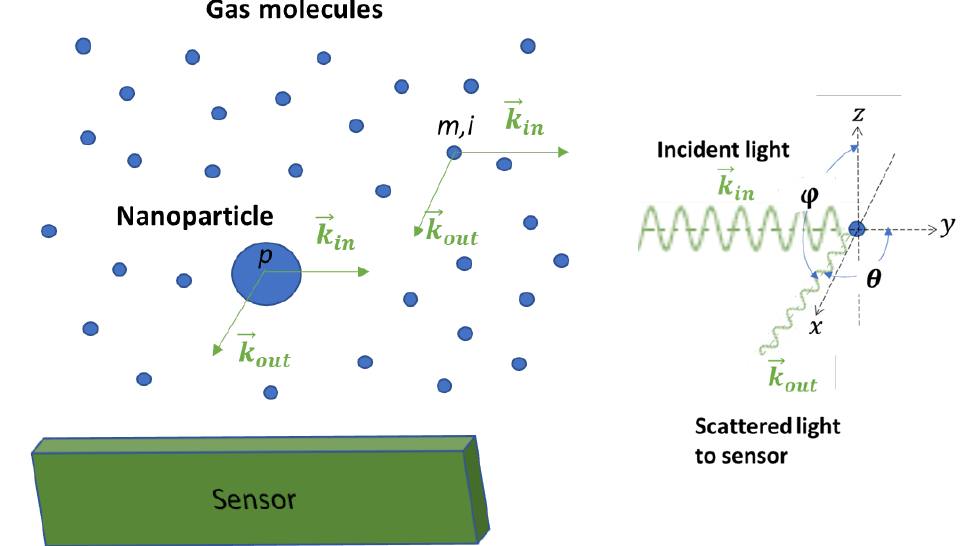
Figure 1. Light scattering when a laser beam irradiates a nanoparticle suspended in the air. Unlike a particle in a vacuum, there are air molecules surrounding the particle, and the effect of light scattering from air molecules should be included in a light scattering model. Using an image detection approach, light scattered from air molecules can be utilized to detect nanoparticles.